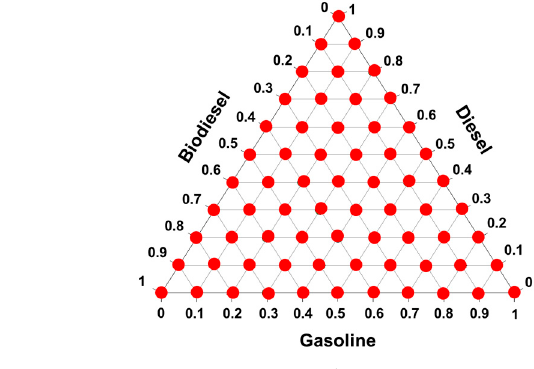
Figure 4. The appearance of gasoline-biodiesel blended fuels (GB) with biodiesel concentrations of ( a ) 20%, ( b ) 15%, ( c ) 10% and ( d ) 5% [Adapted from 106]. Table 2. Physical properties of the fuels. Test Item